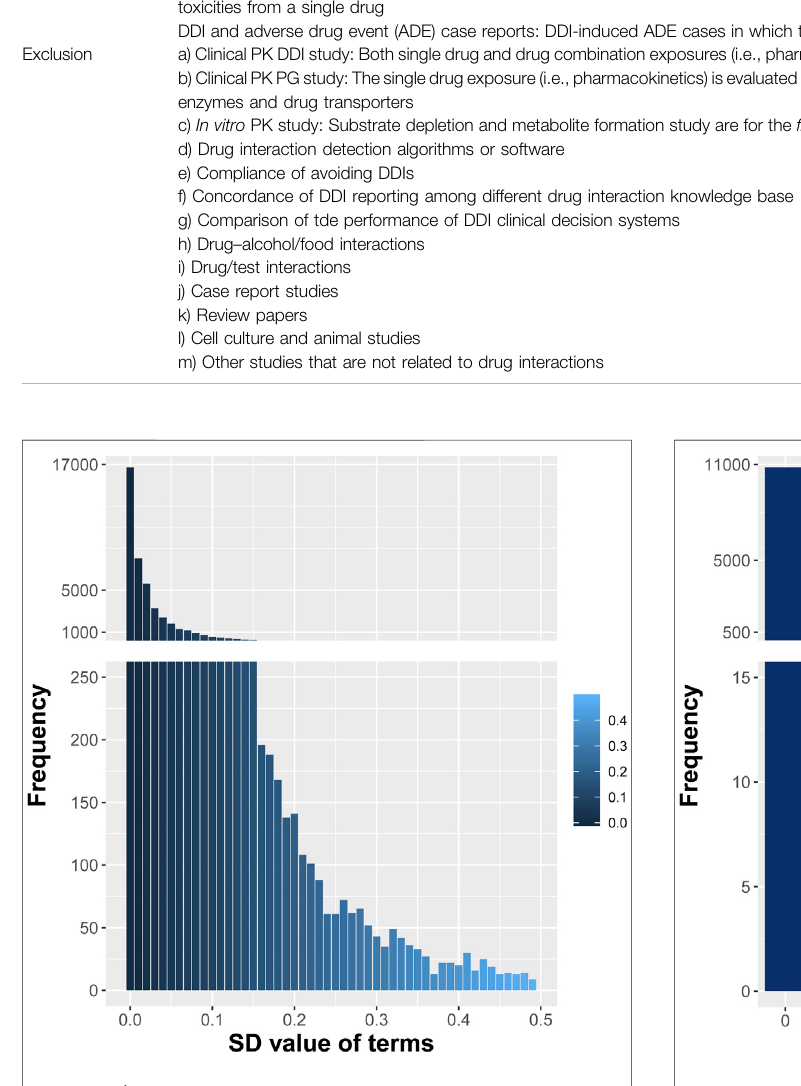
FIGURE2| Frequencydistributionofonerepresentativeterm( “ advanc ” ) in all the selected texts.